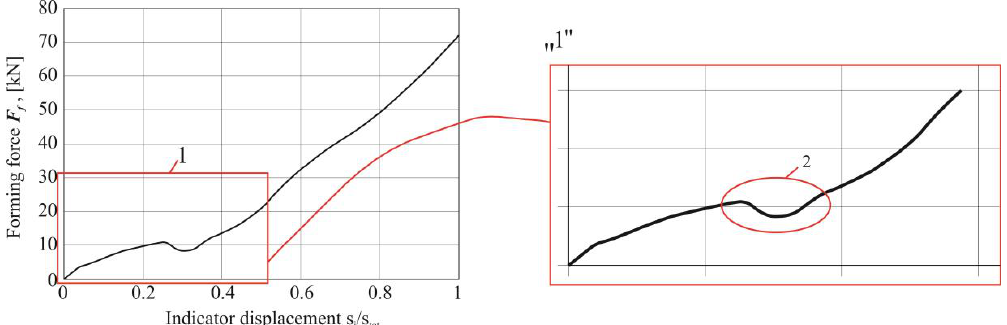
Figure 13. The forming force-displacement diagrams with the characteristic phase of the intensive movement of the rivet in the radial direction (sheet arrangements: AW 5754-H24 and AW